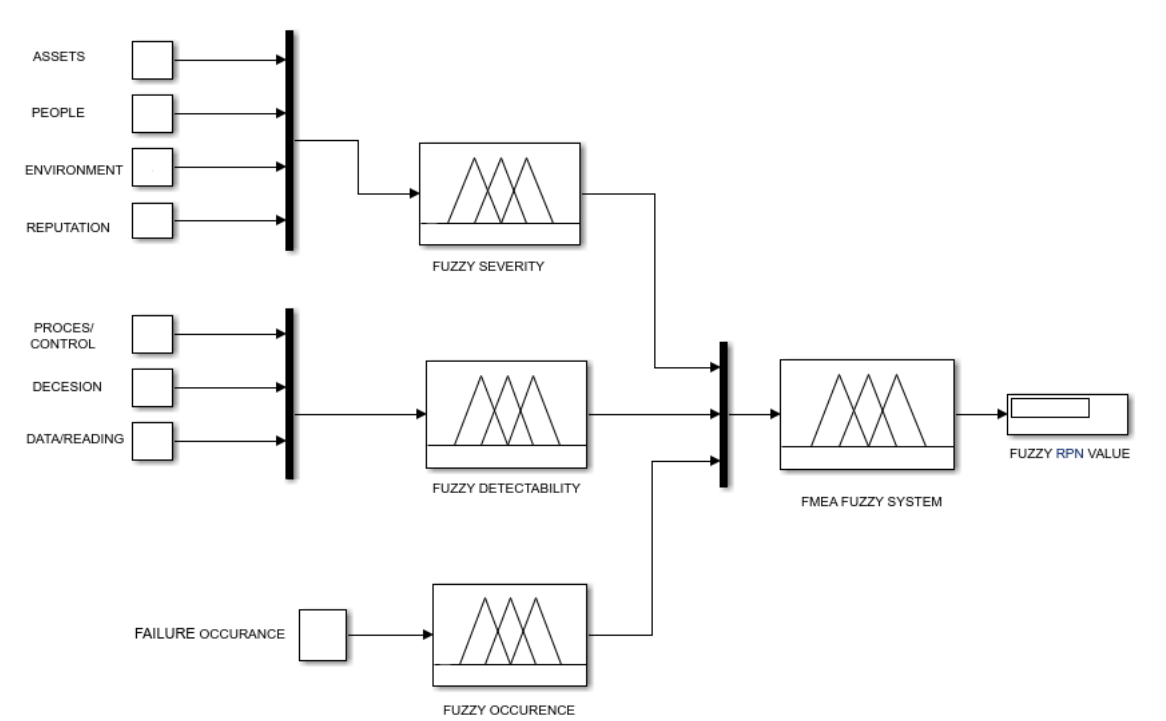
Figure 1. The hierarchy of the four fuzzy logic systems was constructed by using Simulink ® to assess the quantity of the failure mode risk.